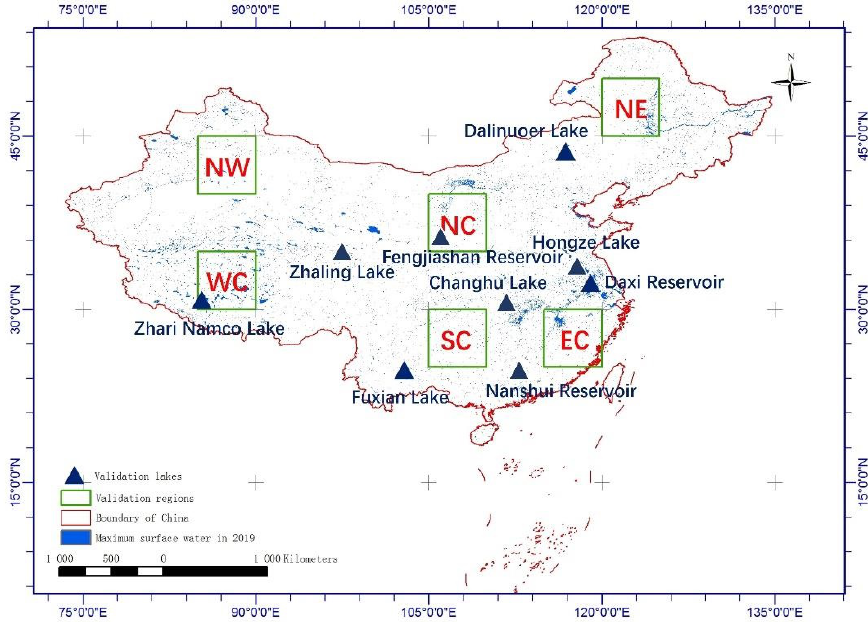
Figure 3. The selected validation regions for accuracy assessment.